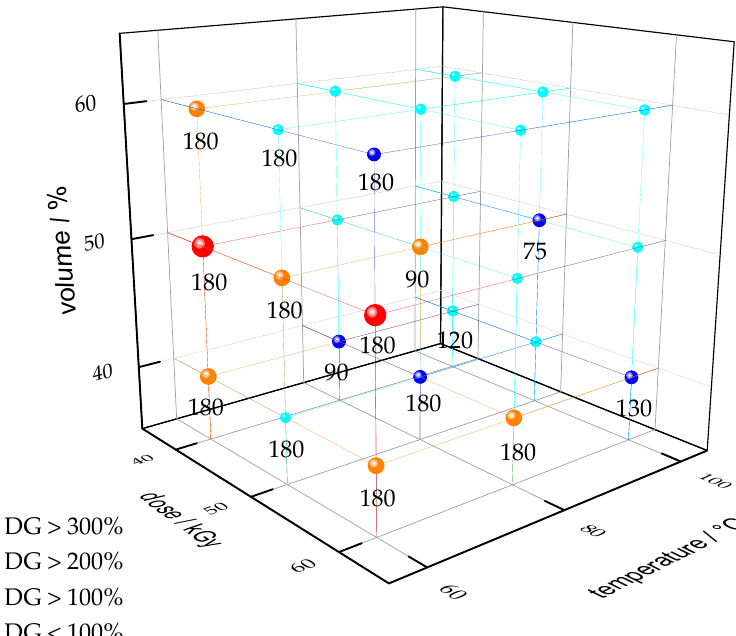
Figure 3. Impact of the influencing variables (reaction temperature, solvent content, and irradiation dose) from the design of experiments on the degree of grafting DG for polymerizations with a monomer feed consisting of 85 mol % GMA, 10 mol % HEMA, and 5 mol % MBAA. The numbers correspond to the reaction time in minutes.